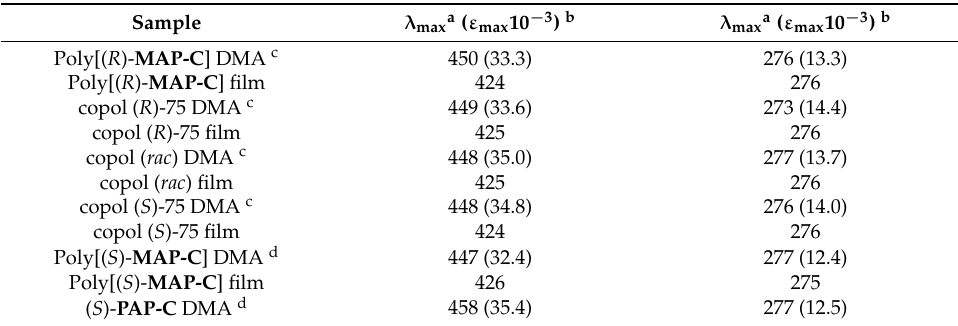
Table 1. UV-Vis spectra of azobenzene derivatives.